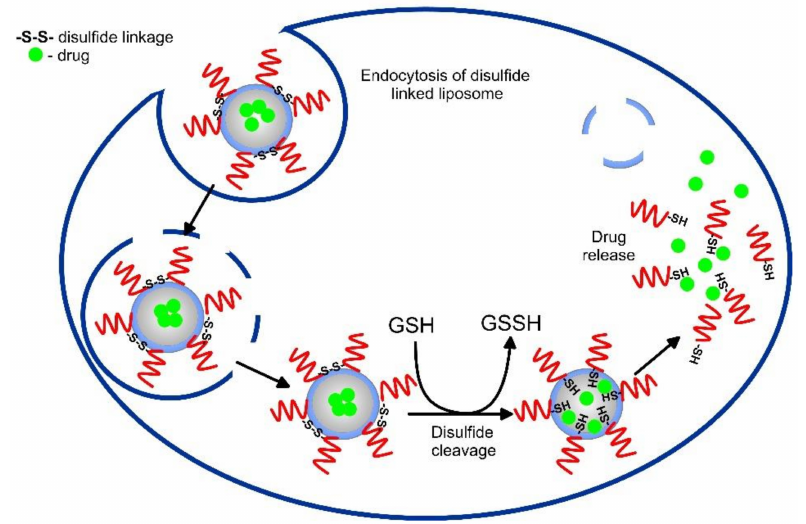
Figure 7. Schematic mechanism of drug release of redox-sensitive liposome that undergoes endo- cytosis, cleavage of the disulfide linkage at a high level of GSH, decomposition of the bilayer, and subsequent release of the encapsulated